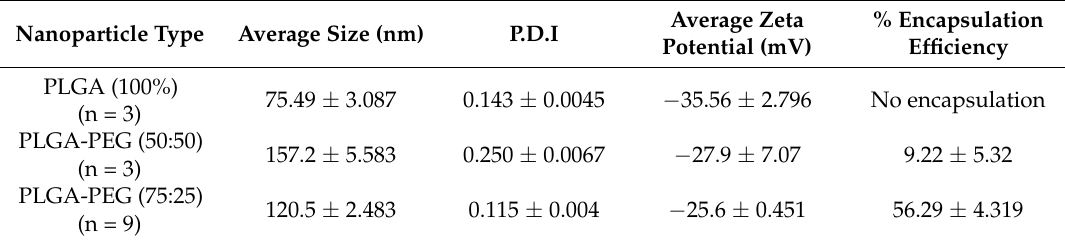
Table 1. Characterization parameters of GSK encapsulated in PLGA nanoparticles and those with different ratios of PLGA-PEG.